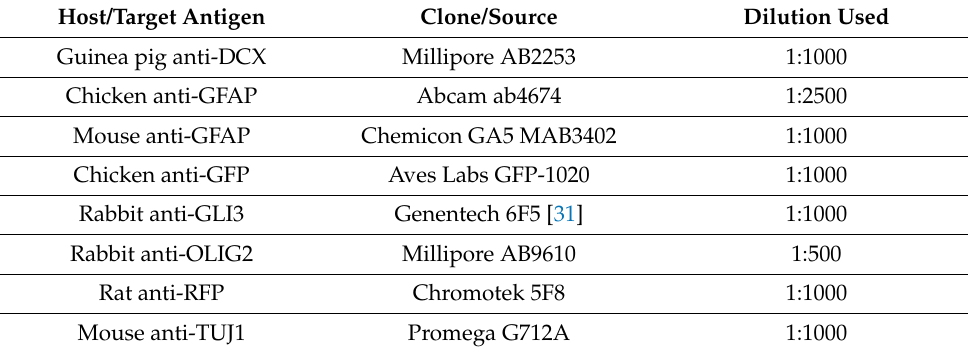
Table 1. Antibodies used for staining show in